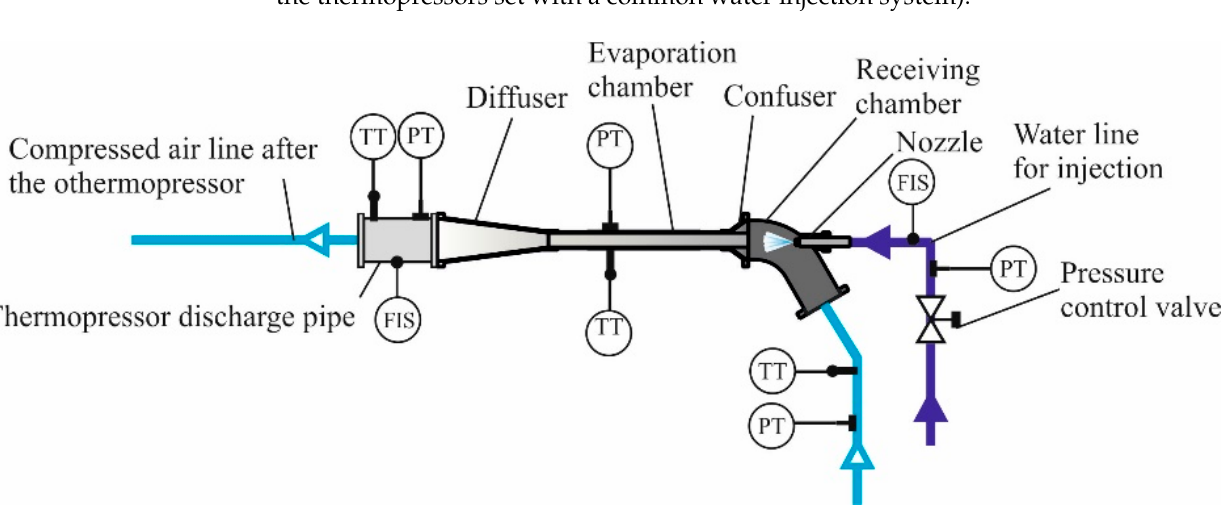
Figure 2. Experimental unit for research of thermopressor characteristics: TT—temperature sensor; PT—pressure sensor; FIS—flow meter.